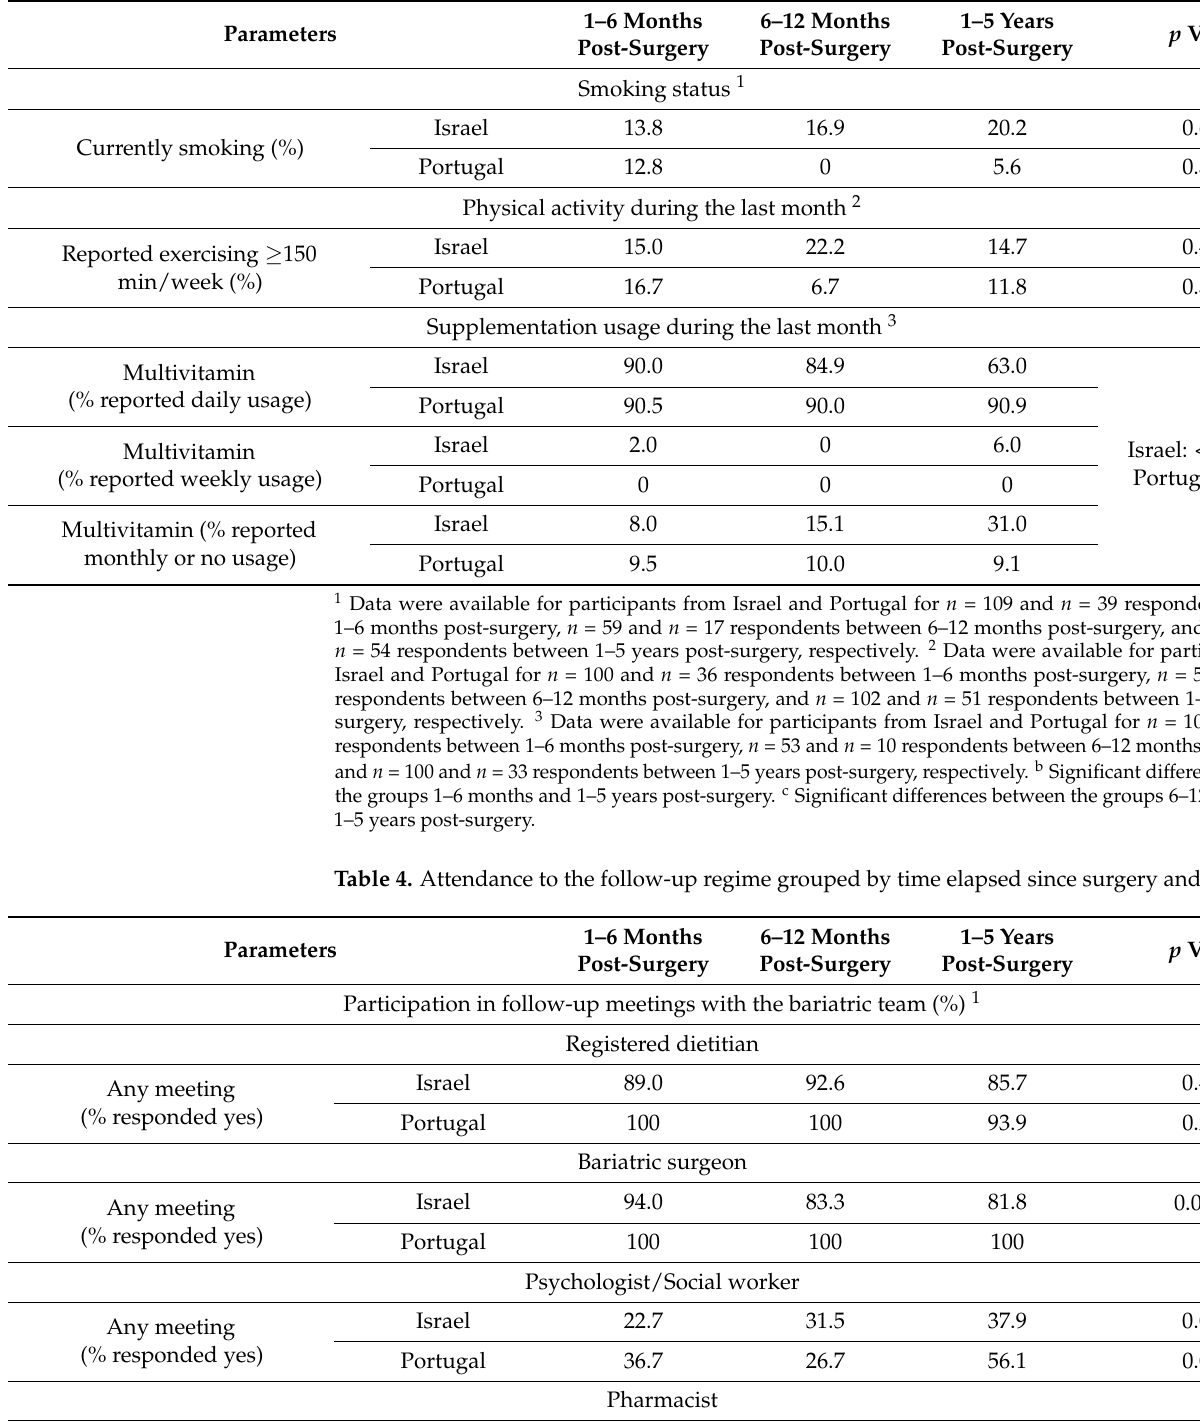
Table 3. Postoperative health behaviors grouped by time elapsed since surgery and by country.